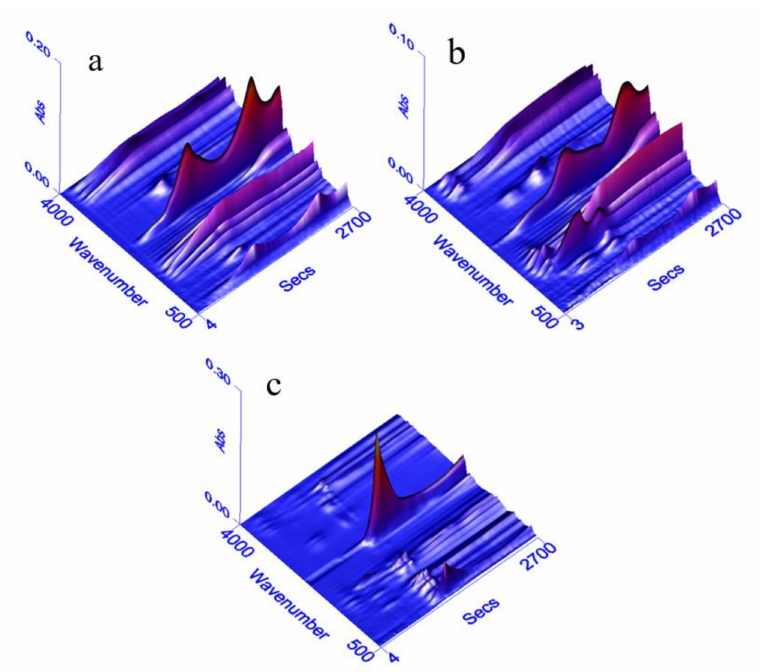
Figure 4. 3D FTIR spectra of the volatile products of Al-lignin ( a ), Ph-lignin ( b ) and F-lignin@APP ( c